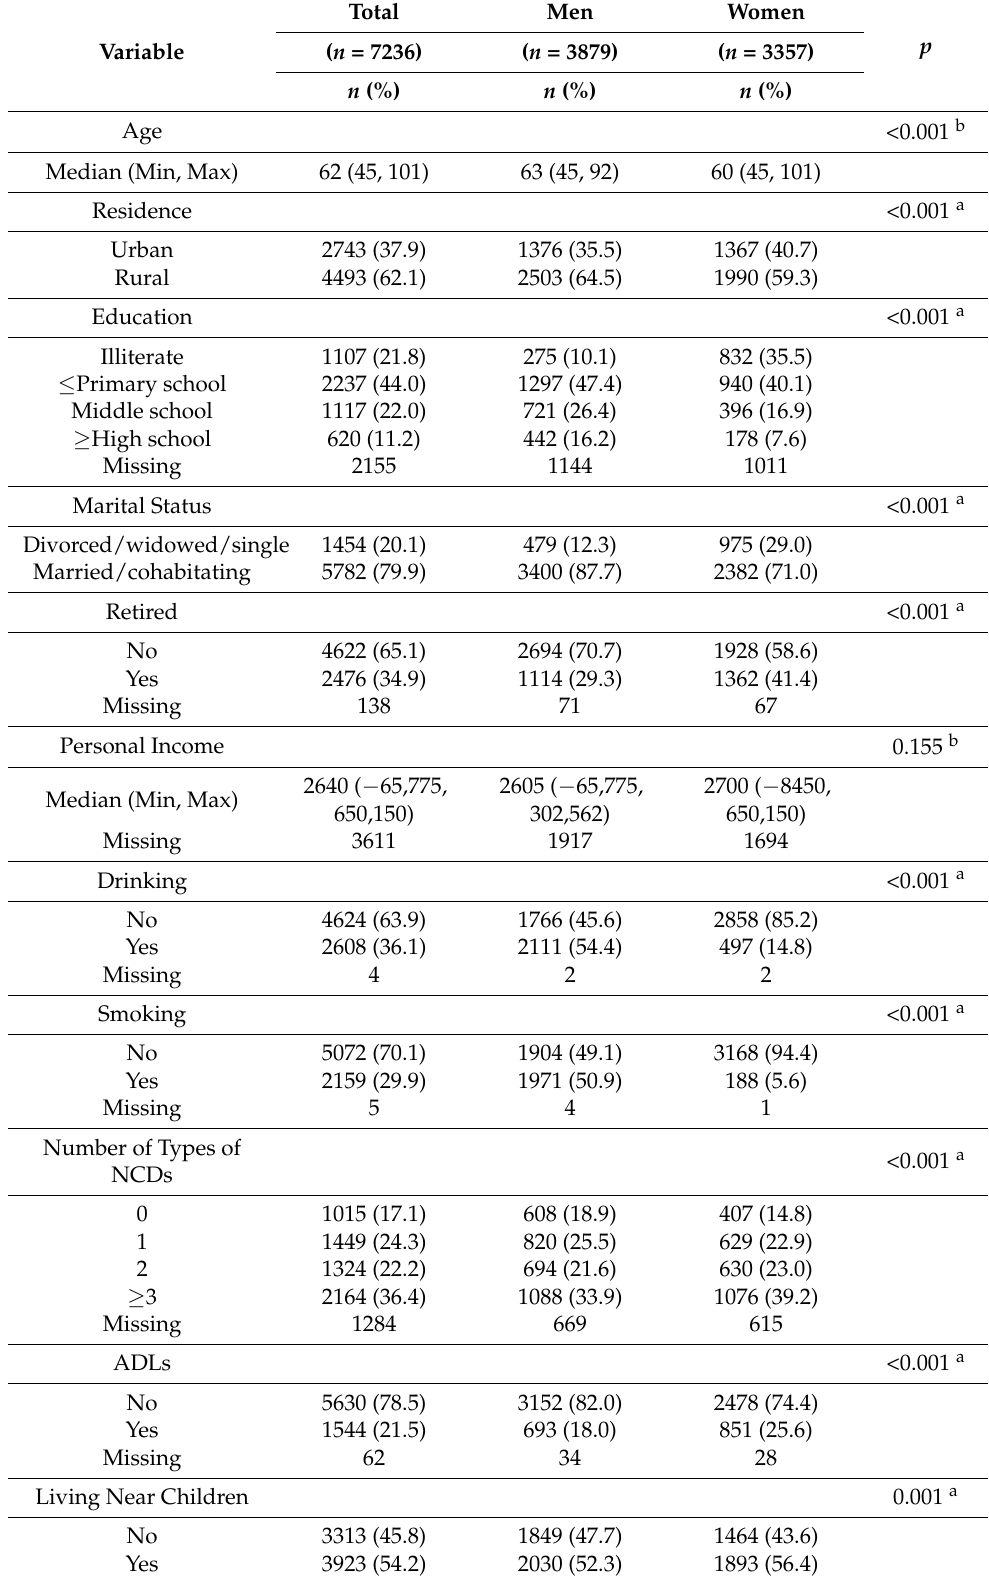
Table 3. Sample characteristics of the selected